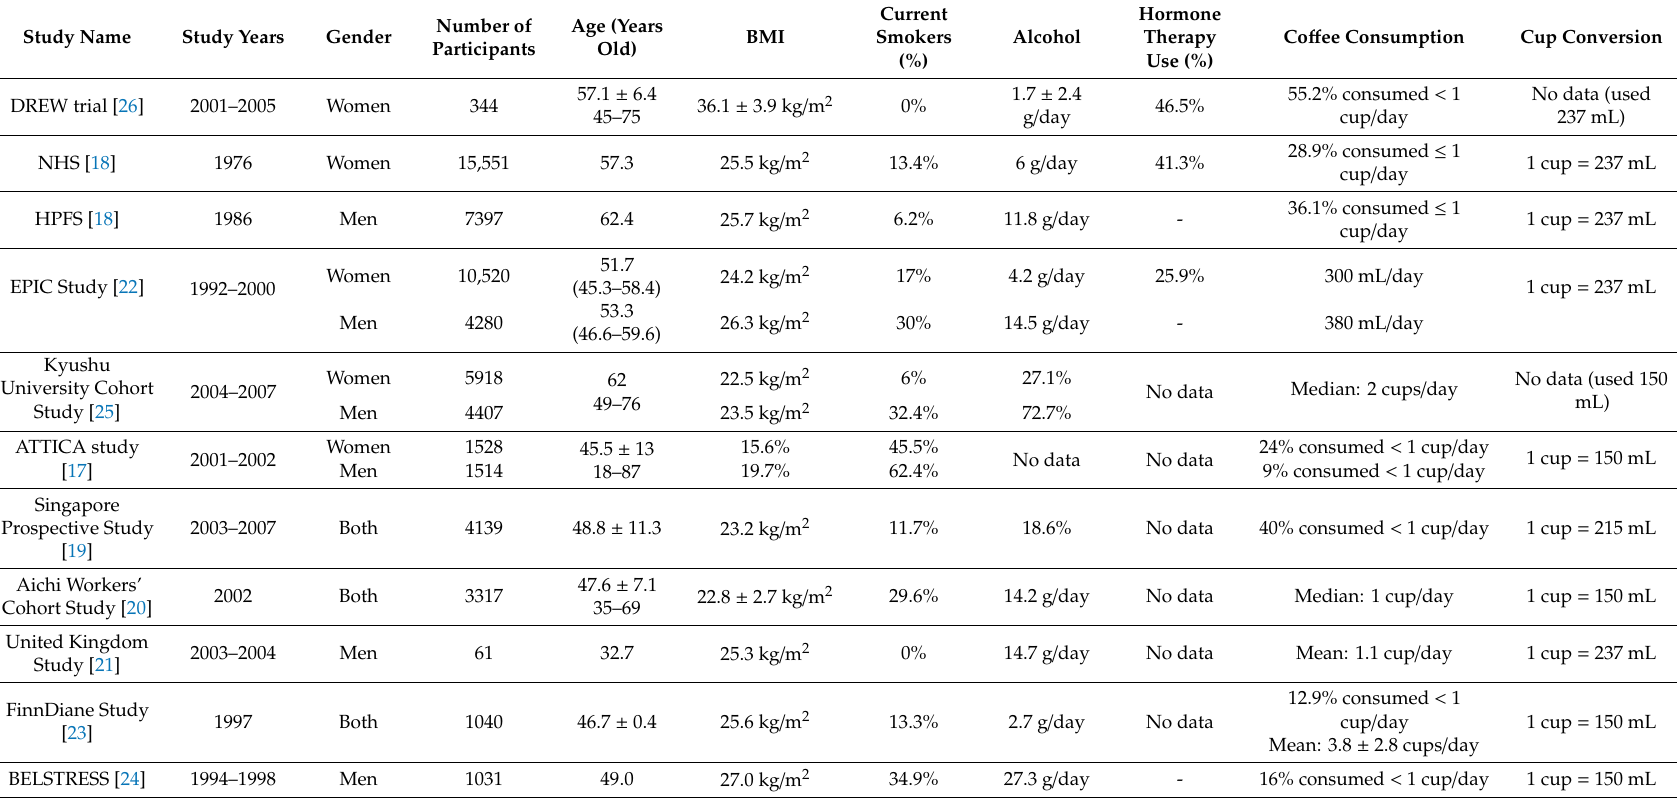
Table 1. Participant characteristics by study